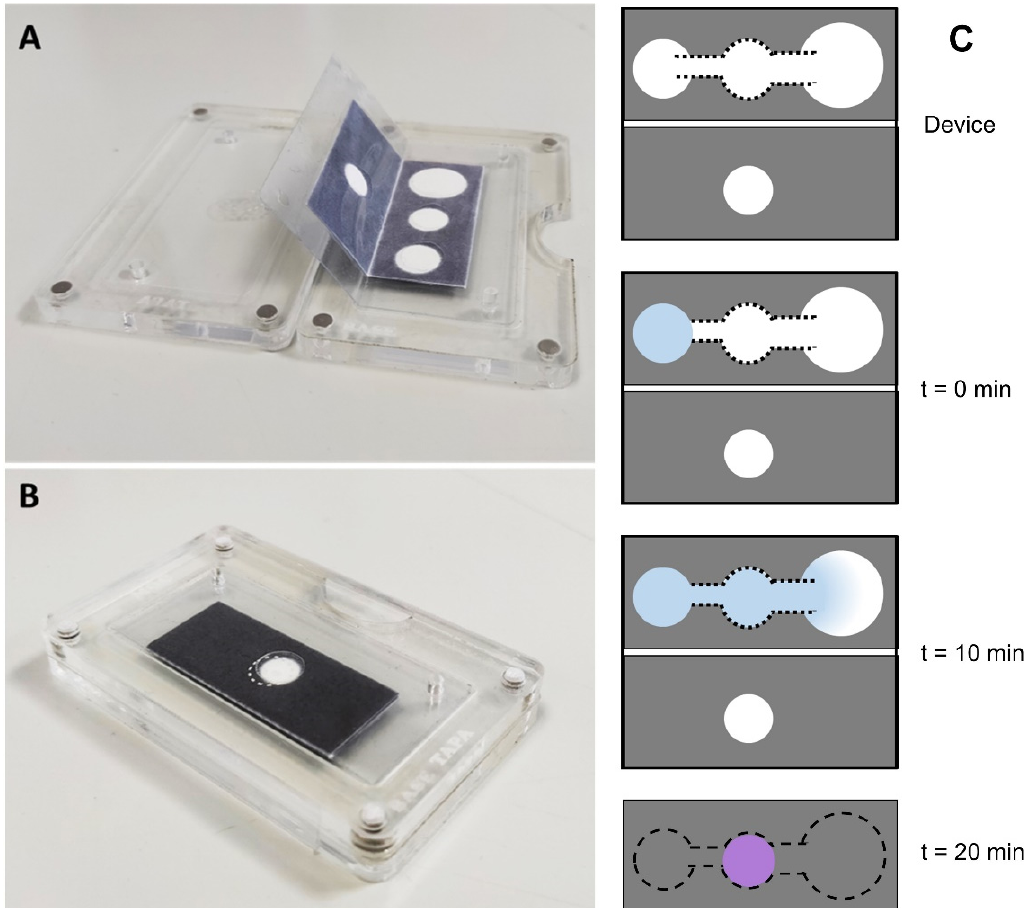
Figure 2. Reusable plastic cartridge to encapsulate the paper-based fluidic device in ( A ) open position and ( B ) closed position. ( C ) Scheme of the analyte fluid movement on the paper device.